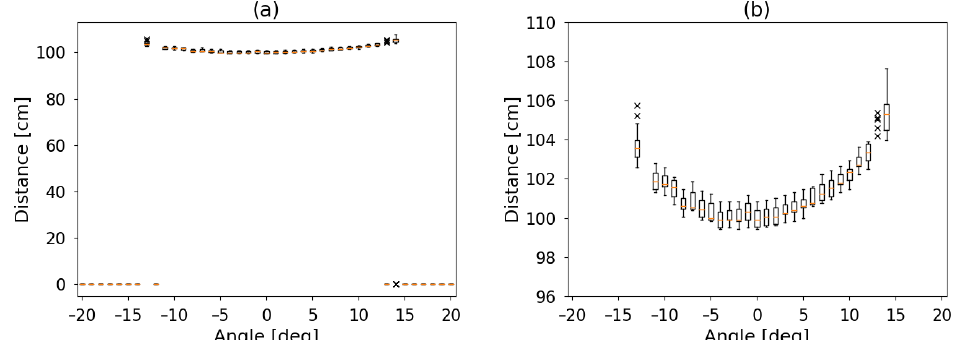
Figure 8. Similar to Figure 7 for a cylinder one meter height and 120 mm of diameter. ( a ) Full range in the left panel. ( b ) values where a detection was performed in the right one. The dispersion for this larger obstacle is lower, and the round shape of the cylinder can be observed. It can also be observed that the detection is not horizontally symmetrical, as the range sensor has the ultrasound emitter on one side and the detector next to it. The object was detected for angles between − 13 and +14 degrees and 2 cm dispersion.